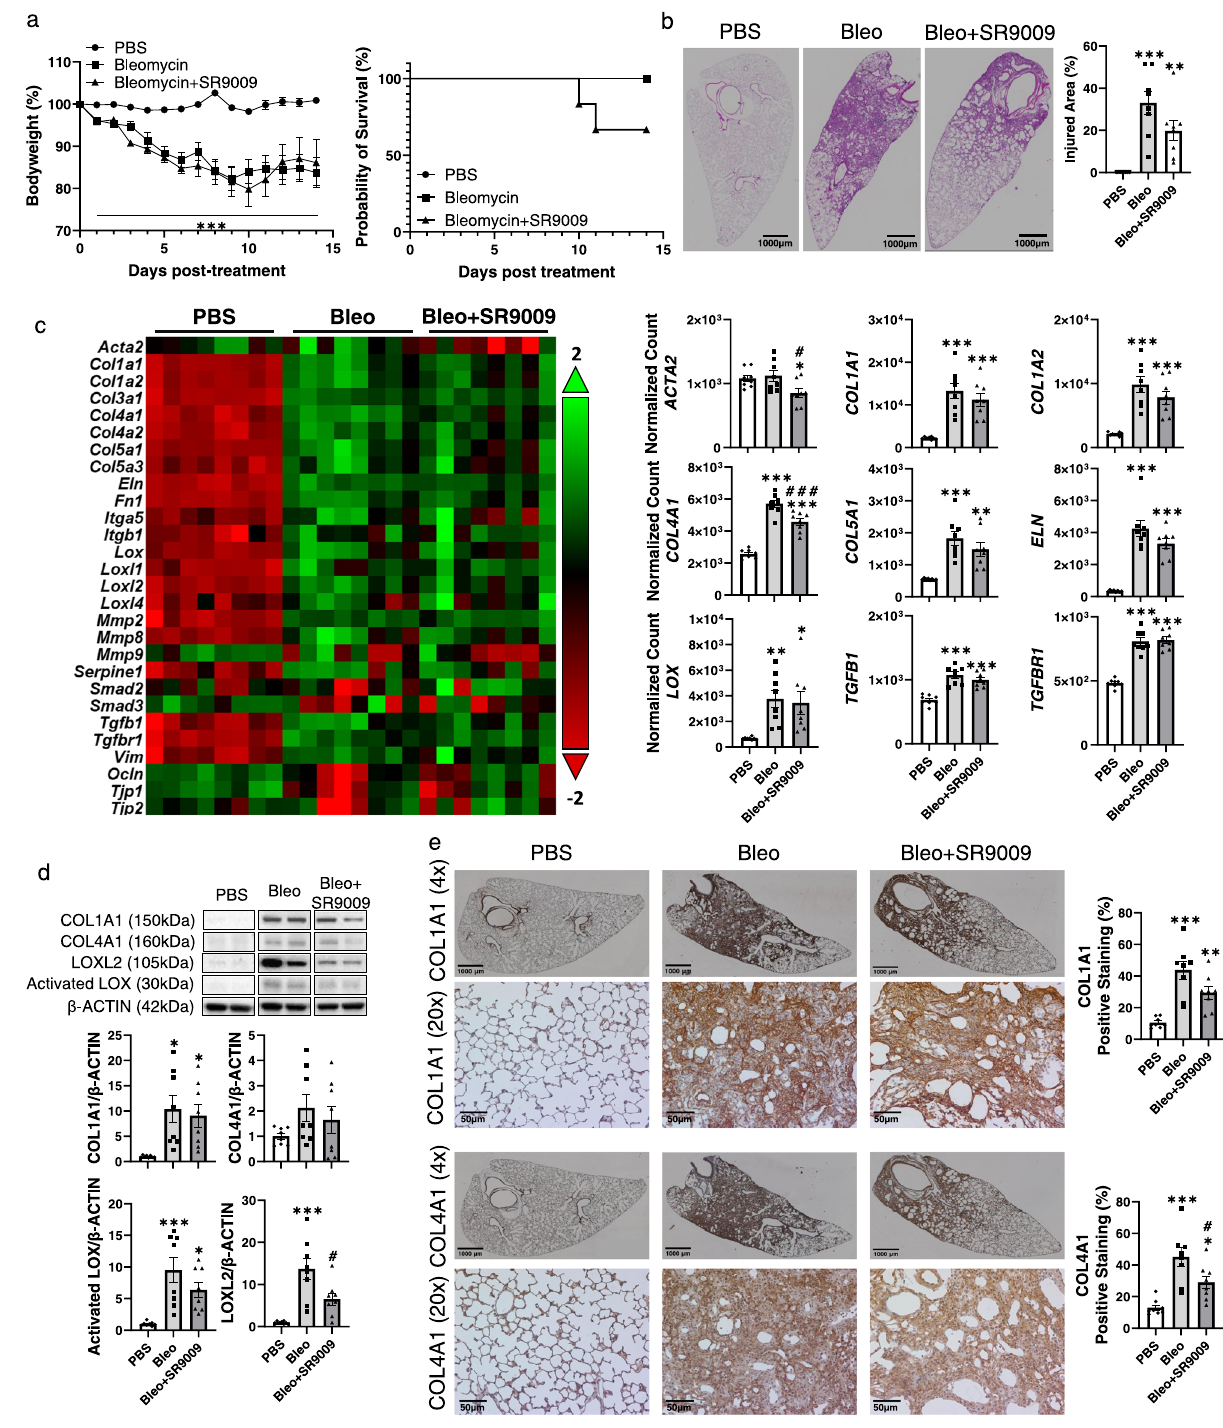
Fig. 4 | Rev-erb α agonist (SR9009) treatment helped to reduce the collagen overexpressionoccurredinbleomycininducedlung fi brosis. C57BL/6JWTmice (equal number of male and female mice) were dosed with bleomycin for 14 days, and SR9009 was given via i.p. injection ata dose of (100mg/kg) daily. a The body weightsandthesurvivalratewasmonitoreduntilday14post-injury( n =8 – 12mice per group). b Lungs were harvested, and H&E staining was performed to identify the injured area percentage ( n =8 mice per group). c RNA was isolated, and gene expression analysis was conducted using nCounter Fibrosis panel via nCounter SPRINT Pro fi ler, and transcripts levels were normalized and visualized by nSolver. The dysregulated genes focused on collagen dynamics and ECM remodeling were